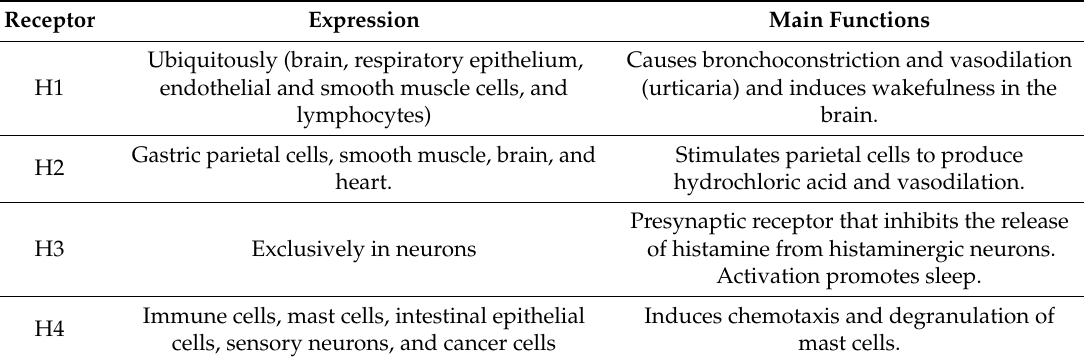
Table 1. Histamine